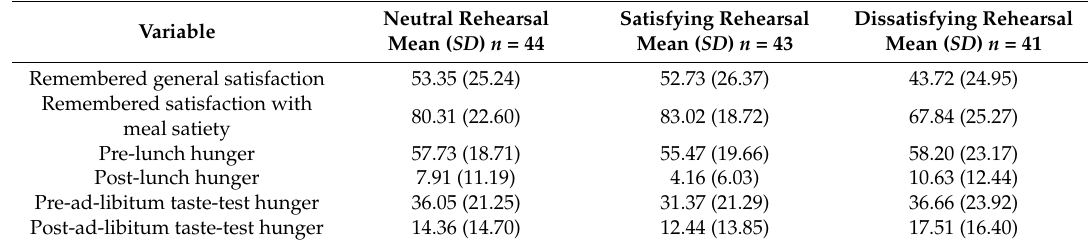
Table 2. Remembered satisfaction and hunger as a function of rehearsal condition.